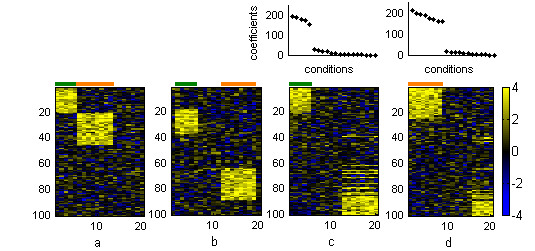
Results from synthetic dataset A (a) Original dataset with the two embedded patterns. (b) Dataset sorted by two-way hierarchical clustering. Dataset sorted by (c) the first basis gene and basis experiment and (d) the second basis gene and basis experiment yielded by nsNMF at k = 3. Conditions belonging to pattern Pla are marked in green and conditions belonging to pattern P2a are depicted in orange. The two plots over the heatmaps represent the coefficients of conditions in each sorted basis gene.